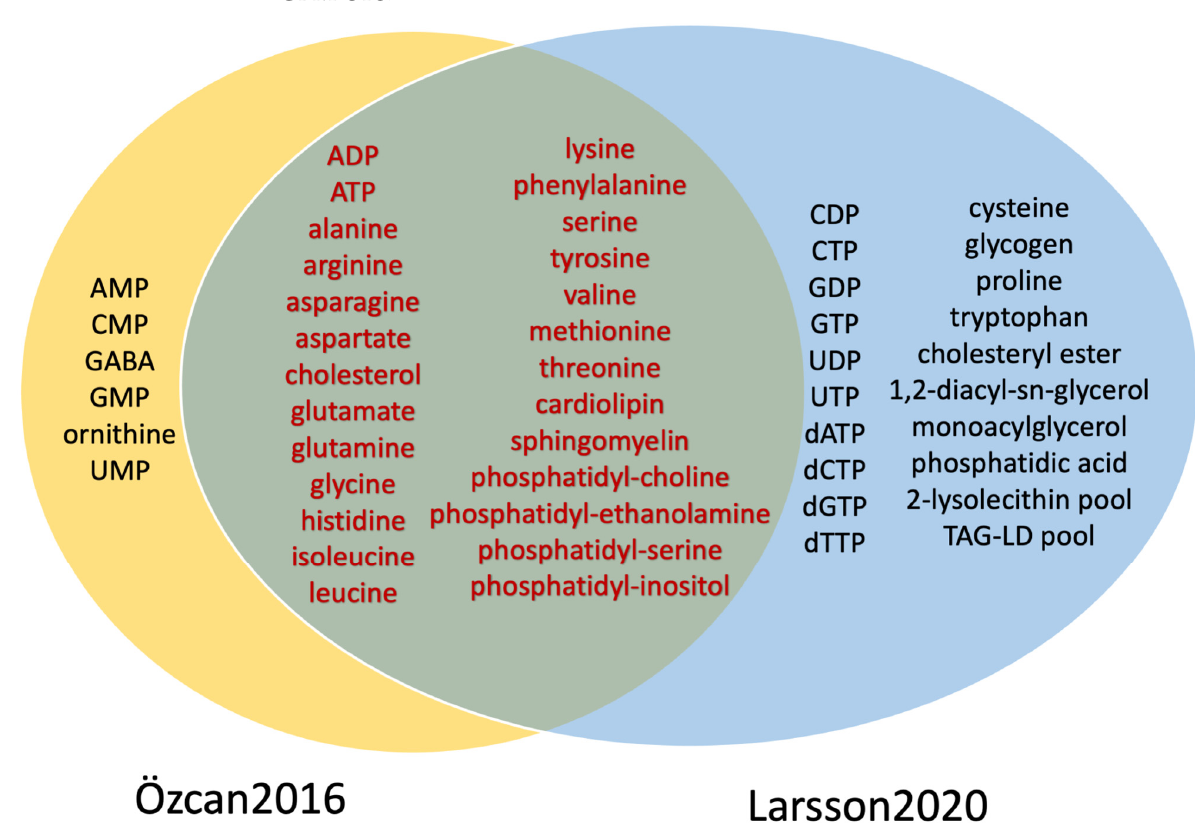
Figure 3. GABA, ornithine and some phospholipids are different between the tailored glioblastoma and the generic OFs. Two brain GEMs have a biomass function: Özcan2016 and Larsson2020. Both models’ OFs share 26 metabolites, mostly amino acids, cholesterol, and phospholipids. While Özcan2016’s OF has six unique metabolites, notably GABA and ornithine, Larsson2020’s OF has 20 unique metabolites such as cysteine, glycogen, proline, tryptophan, nucleotides and fatty acids.